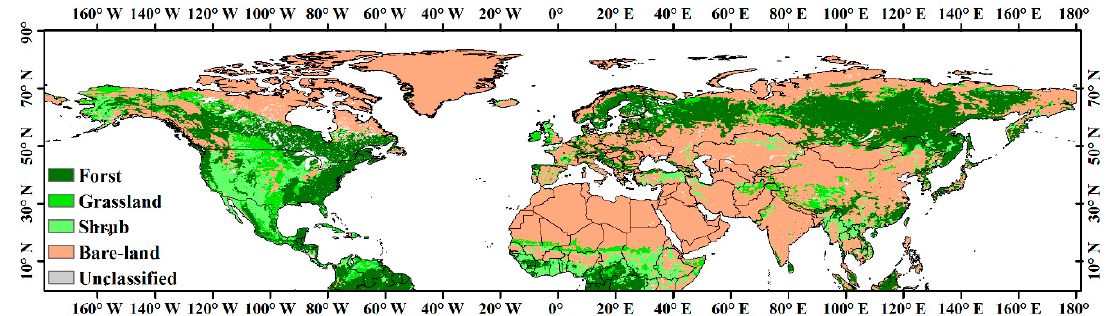
Figure 1. Land cover classification of the Northern Hemisphere (Forest, Grassland, Shrub, Bare-land and Unclassified) based on GlobCover 2009.